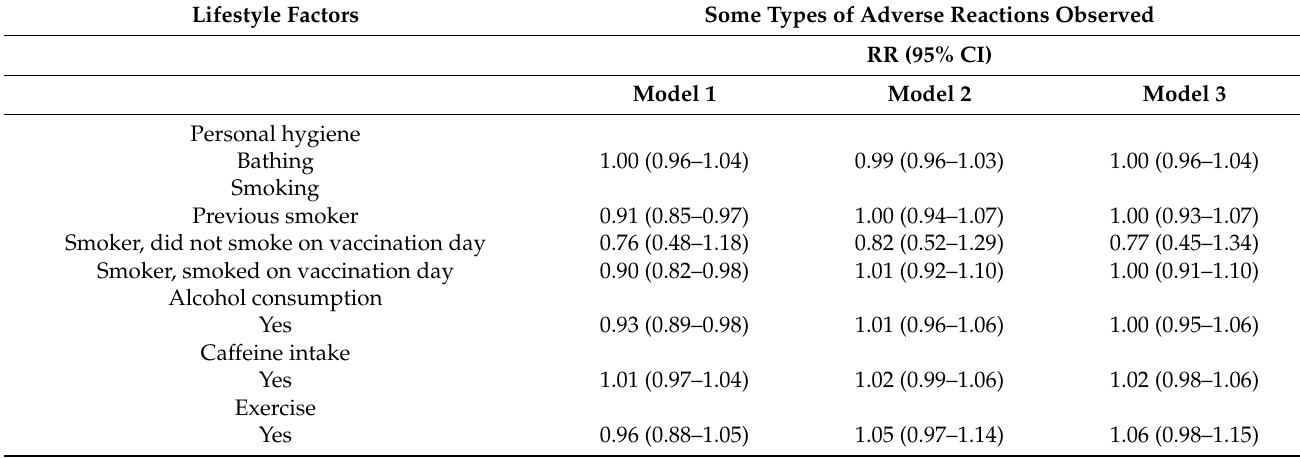
Table 3. Effect of lifestyle factors on the incidence of some types of adverse reactions (local or systemic).